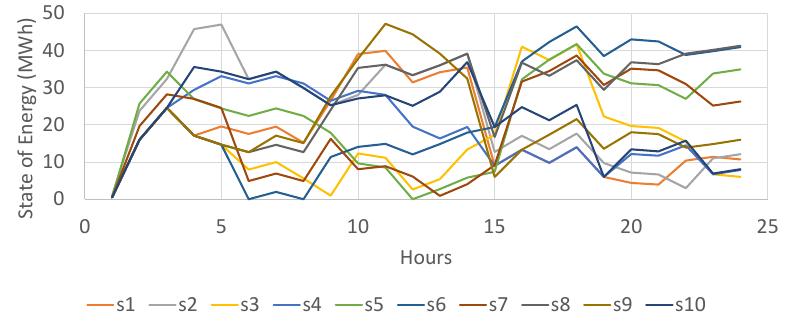
Figure 7. Propagation of the battery storage state-of-energy ( soe t , s ) per scenario.